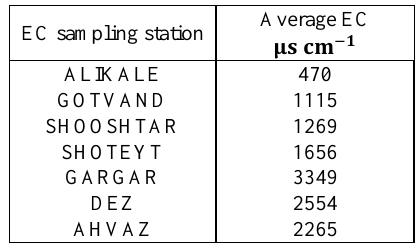
Table 1. The average of EC at each station